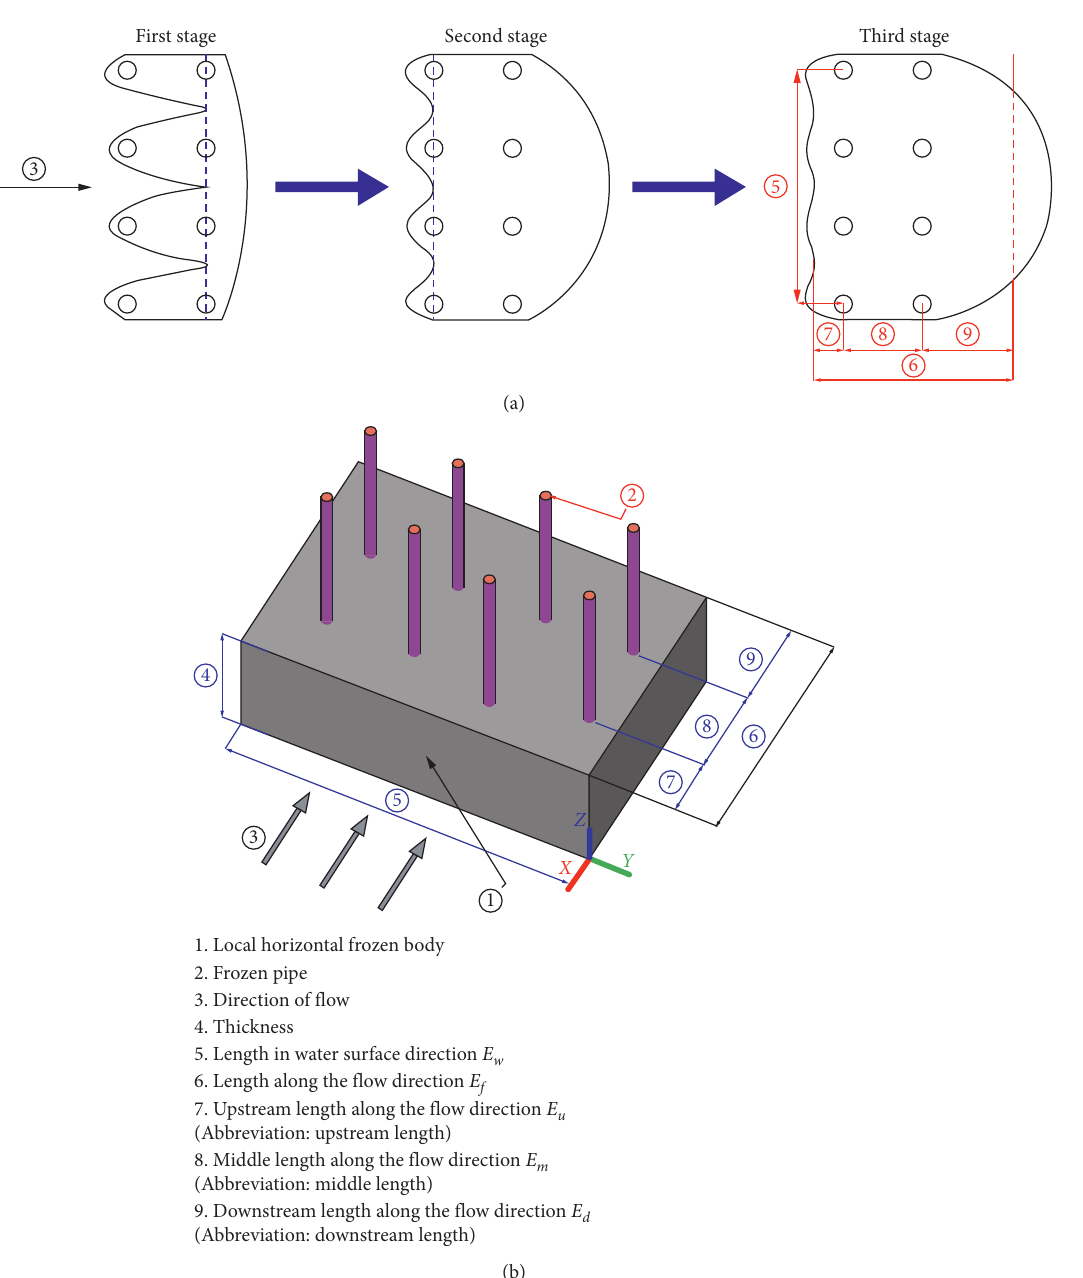
Figure 4: Schematic diagram of the horizontal frozen body. (a) Parameters of each stage. (b) Schematic diagram of horizontal frozen body